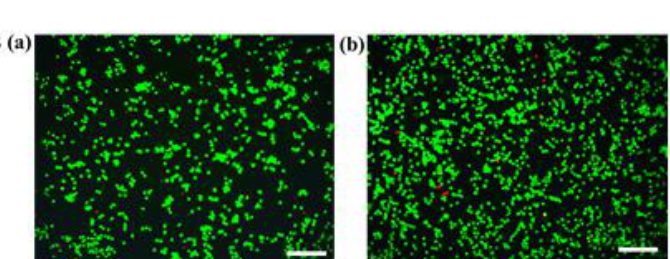
Figure 5. ( A ) Proliferation of the RAW 264.7 cells cultured on the surfaces of the PLL- g -Dex or the culture plates (without PLL- g -Dex). * p < 0.05. ( B ) Viability and morphology of the RAW 264.7 cells cultured on surfaces of (a) the culture plates and (b) PLL- g -Dex for 24 h (green cells are live, and red cells are dead; the scale bar is 200 μm).